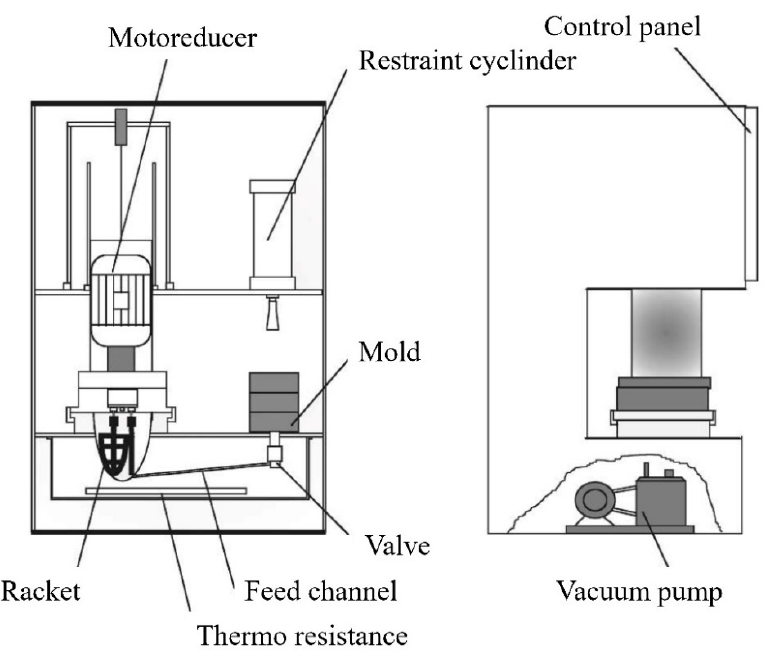
Figure 4. Schematic illustration of LPIM machine. Reproduced with permission from reference [141], copyright © 2001 Elsevier Science B.V. copyright © 2001 Elsevier Science